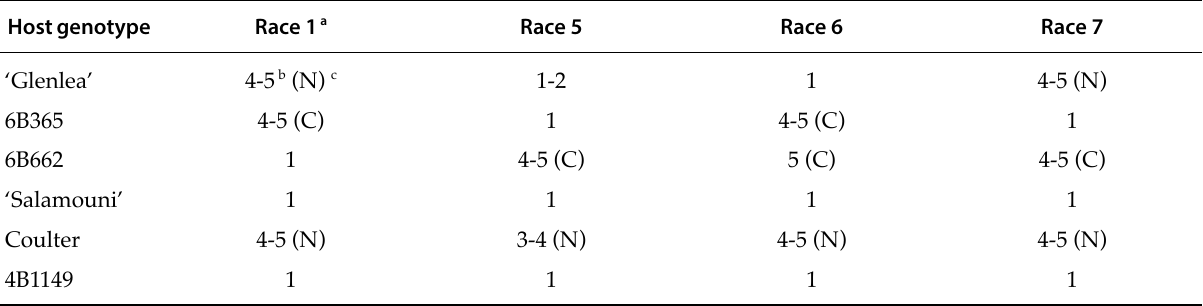
Table 1. Reaction phenotypes produced by the four races of Pyrenophora tritici-repentis identified in Morocco during 2013- 2015 on the six international wheat